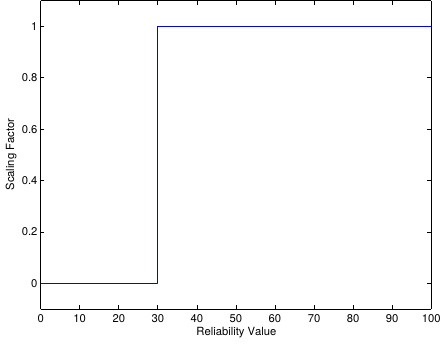
Figure 8. Scaling factor for the reliability